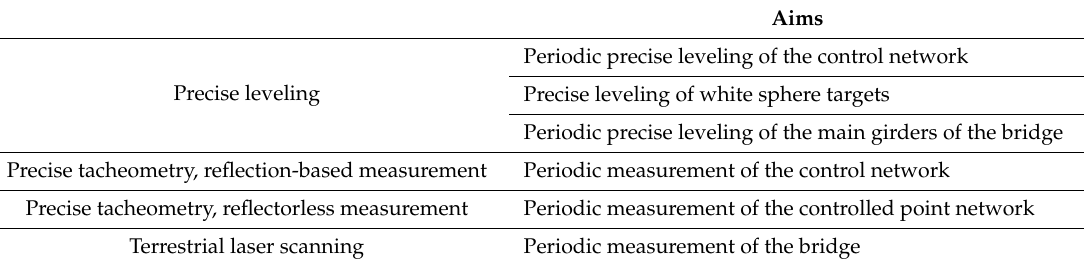
Table 3. Measurement methods and their aims.